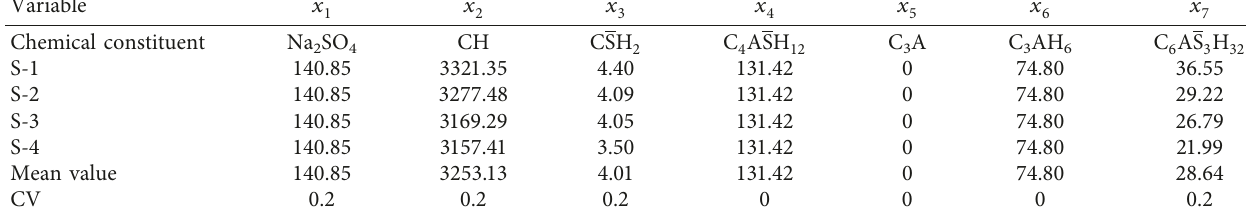
Table 1: Chemical constituents represented by x Variable